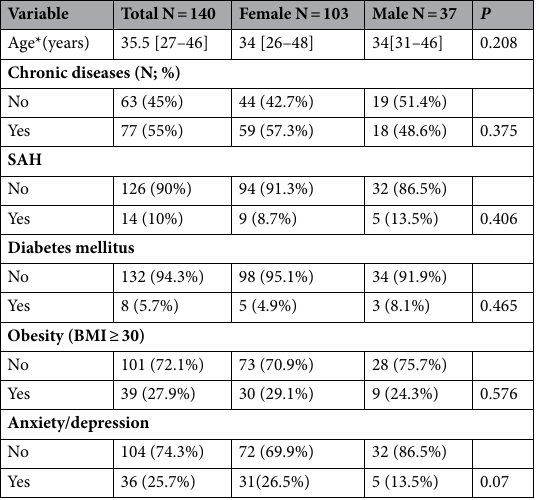
(Table 3). Only sex, anxiety/depression, dyspnea after 30 days, dyspnea after one year, fatigue after 30 days, fatigue after one year, and persistent symptoms after one year remained associated with the dependent variable functional limitation after one year (omnibus tests of model coefficients P < 0.001).